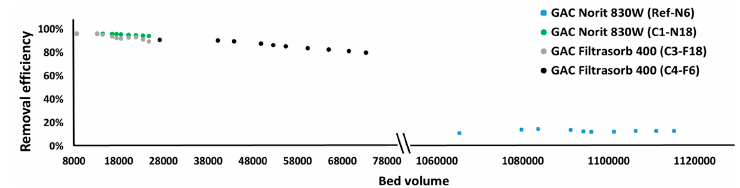
Figure 5. Removal efficiency profile as a function of number of bed volumes for all seven organic micropollutants in the full-scale granulated activated carbon (GAC) filter containing GAC type Norit 830W (Ref-N6), and in the pilot-scale GAC columns containing Norit 830W (C1-N18), Filtrasorb 400 (C3-F18) and Filtrasorb 400 (C4-F6). The x -axis is truncated at 1,060,000 BV.